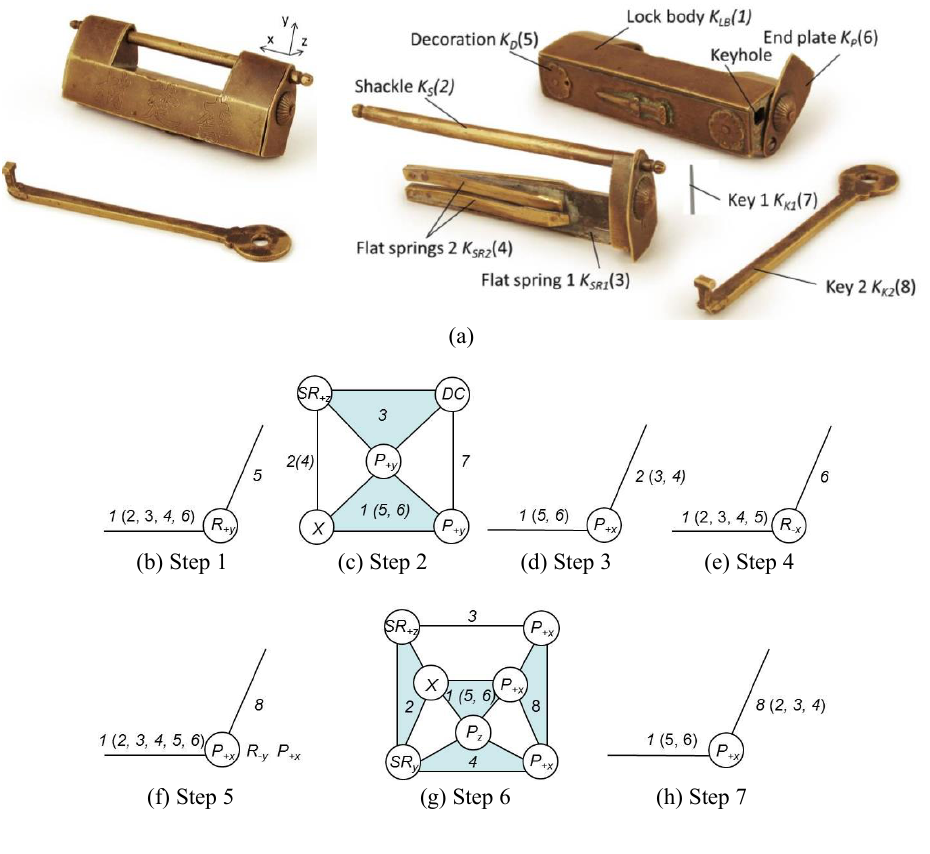
Figure 9. Padlock with a rotating